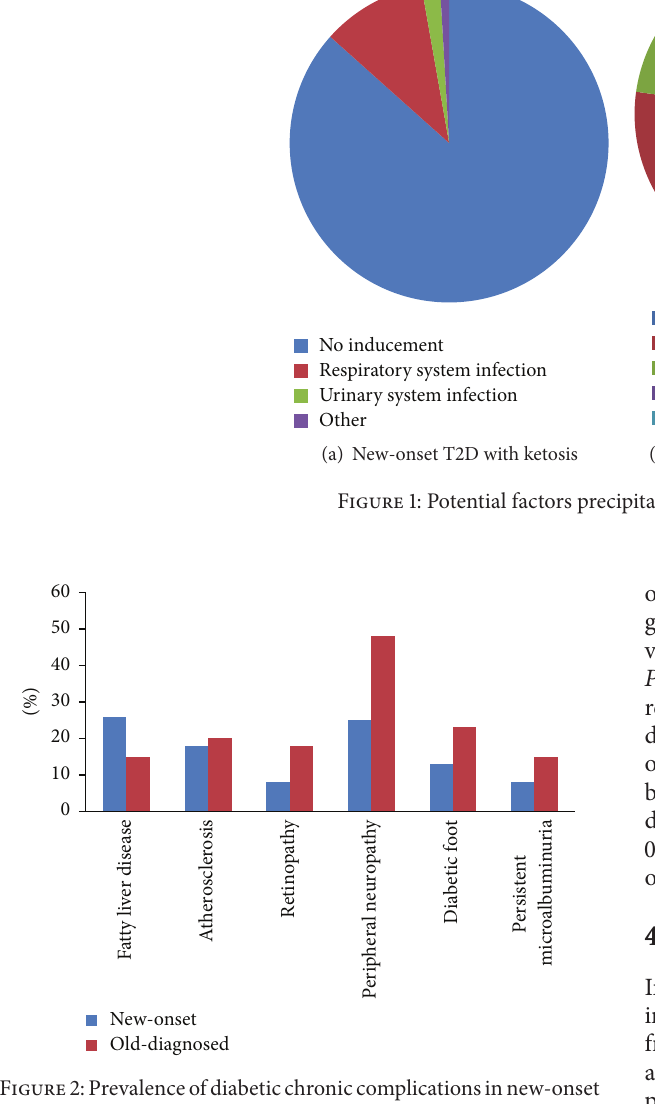
Figure2:Prevalenceofdiabeticchroniccomplicationsinnew-onset and old-diagnosed T2D with